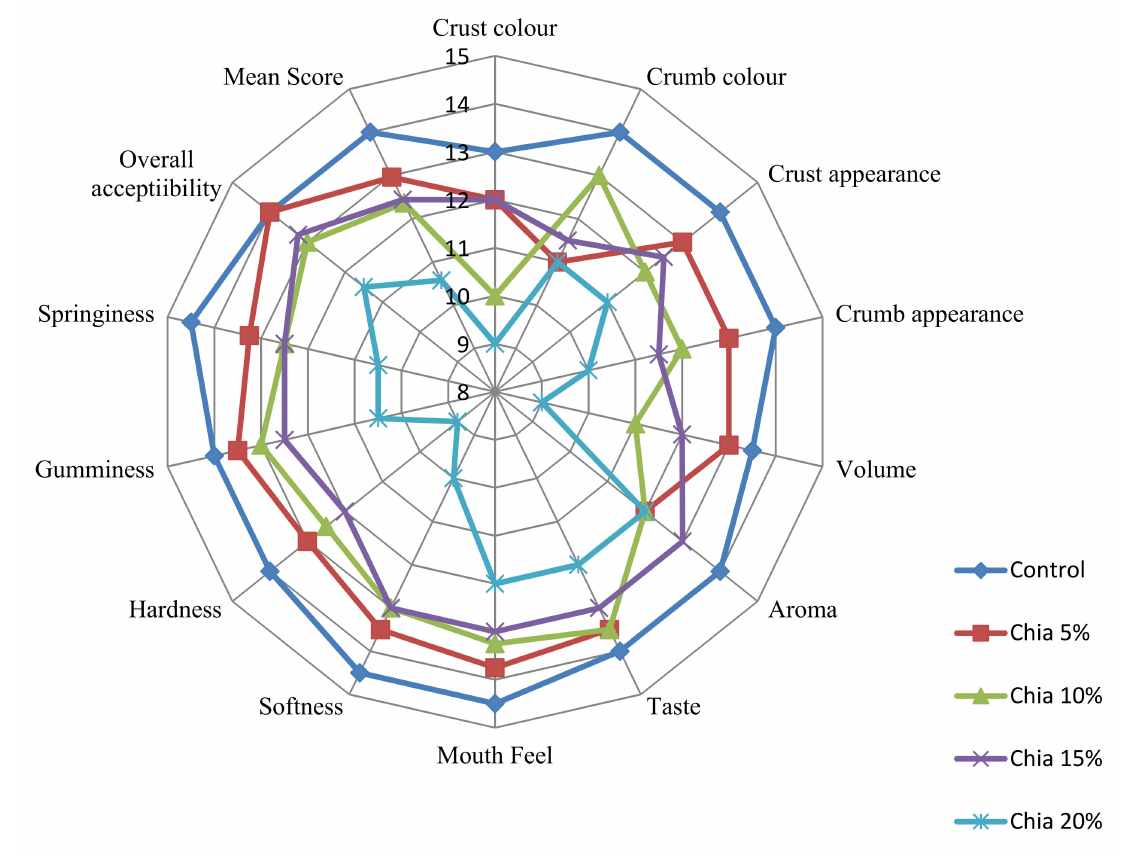
Figure 2. Sensorial Web for Sensory Study of